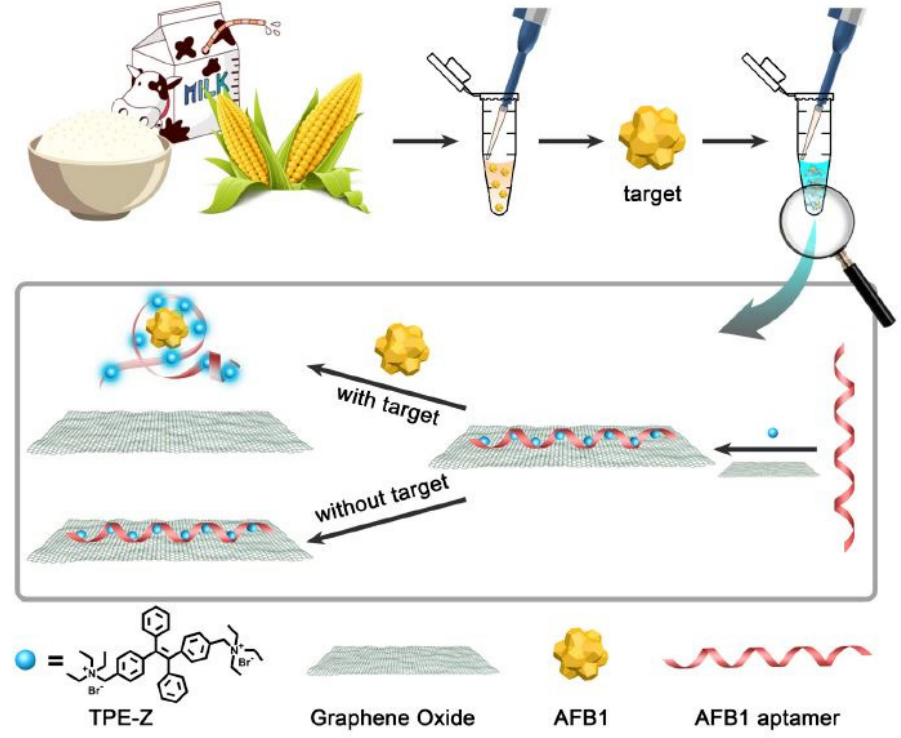
Figure 4. The working mechanism of the TPE-Z/AFB1 aptamer/GO-based devices for the detection of AFB1 molecules in different types of food samples [112]. Reproduced from Jia, Y., Wu, F., Liu, P., Zhou, G., Yu, B., Lou, X. and Xia, F., 2019. A label-free fluorescent aptasensor for the detection of Aflatoxin B1 in food samples using AIEgens and graphene oxide. Talanta , 198 , pp. 71–77.